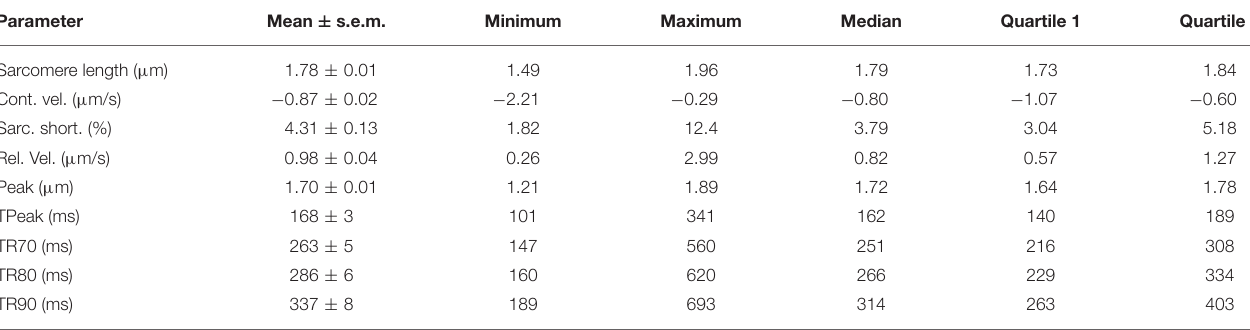
TABLE 3 | Distributions of baseline values of the contractility parameters in 189 human ventricular cardiomyocytes from 11 donor hearts. Parameter Mean ± s.e.m. Minimum